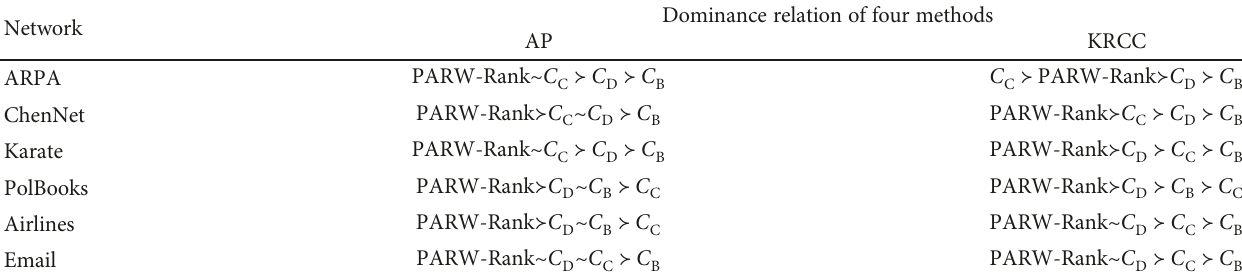
Table 7: The summary of the e ff ects of four methods for ranking node in fl